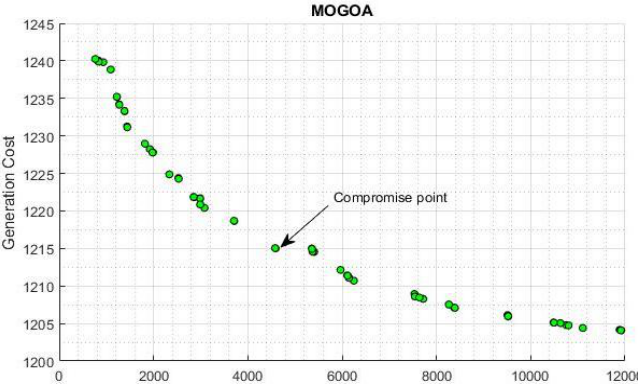
Figure 2. Generation and Rescheduling Cost Convergence curve by MOGOA (Case